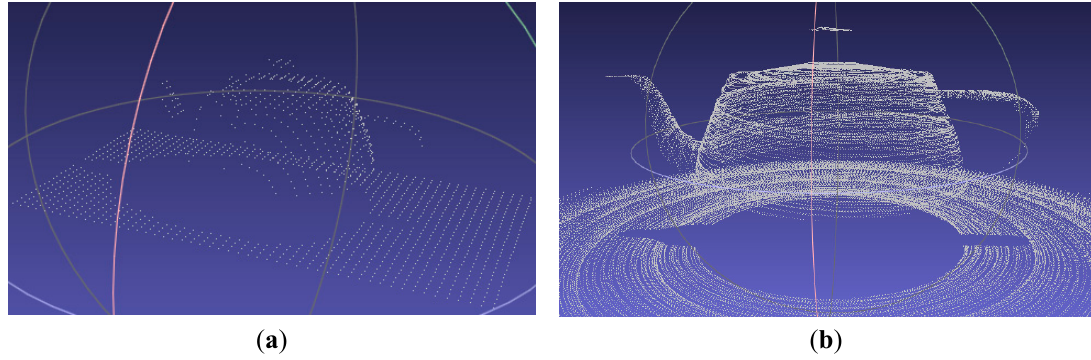
Figure 5. Simulation results at the end of the 3D object scan simulation.